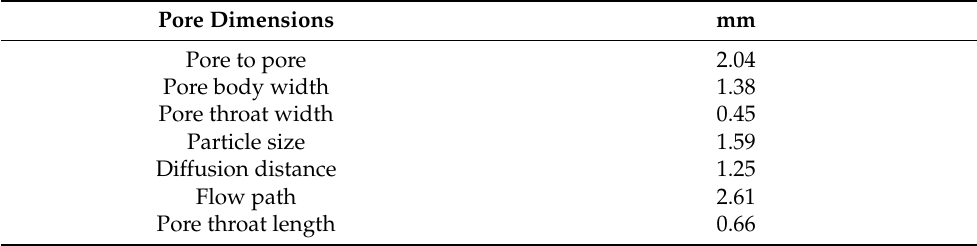
Table 2. OC-1 micromodel characteristic